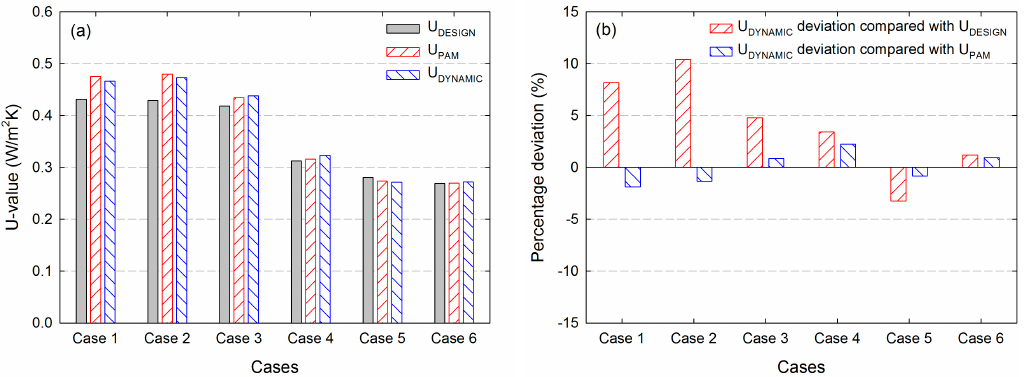
Figure 7. ( a ) (cid:1847) -values; (b ) their percentage deviations estimated by calculation method, progressive Figure 7. ( a ) U -values; ( b ) their percentage deviations estimated by calculation method, progressive average method, and dynamic method. average method, and dynamic method.